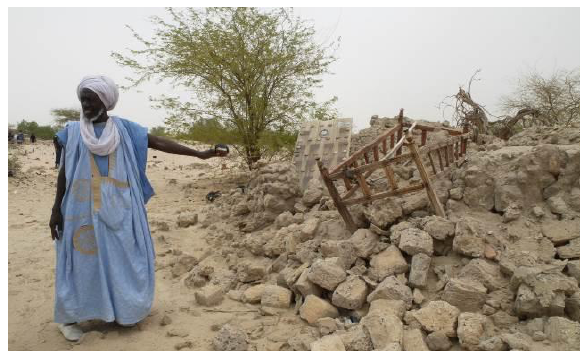
Figure 1. Mausoleum of Cheik Sidi Ben Amar, destroyed on June 30, 2012 © Joffroy T.